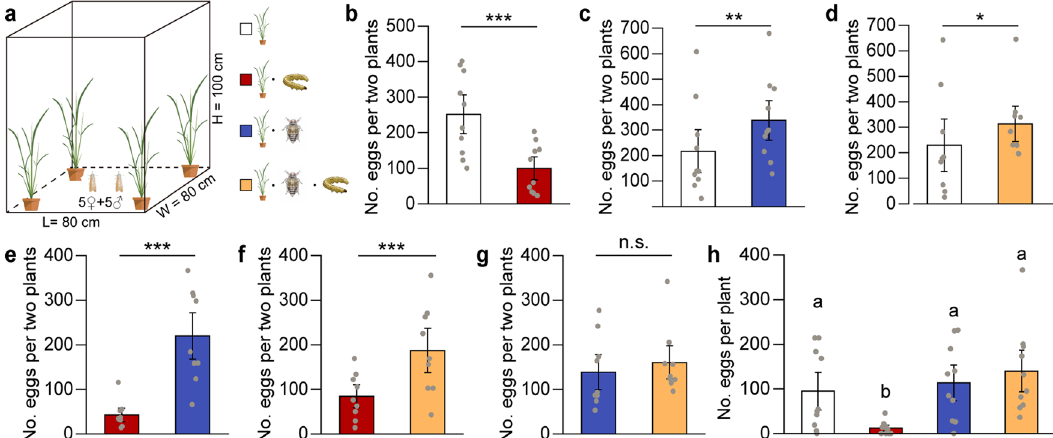
Fig. 2 Oviposition preference of SSB moths in greenhouse experiments. Number of eggs laid by female C. suppressalis on rice plants that were either uninfested (Control), infested by SSB larvae only (SSB), BPH only (BPH), or by both SSB and BPH (SSB/BPH). a Schematic drawing of the oviposition experiments. b Control versus SSB larva-infested plants ( n = 10). c Control versus BPH-infested plants ( n = 11). d Control versus dually infested plants ( n = 9). e SSB larva-infested plants versus BPH-infested plants ( n = 9). f SSB larva-infested plants versus dually infested plants ( n = 9). g BPH-infested plants versus dually infested plants ( n = 9). h SSB female moths were exposed to the four types of rice plants all together ( n = 10). For b – g , exact P - values = 3.52e-07 (Control vs SSB), 0.0068 (Control vs BPH), 0.032 (Control vs SSB/BPH), <2.2e-16 (SSB vs BPH), 9.03e-05 (SSB vs SSB/BPH), 0.20 (BPH vs SSB/BPH); For h , exact P -values = 2.15e-04 (Control vs SSB), 0.87 (Control vs BPH), 0.22 (Control vs SSB/BPH), <1e-04 (SSB vs BPH), <1e-04 (SSB vs SSB/BPH), and 0.67 (BPH vs SSB/BPH). Two-sided likelihood ratio test with generalized linear mixed model was conducted for the number of eggs (Poisson distribution error). Each bar represents the mean ± SE. Data columns with asterisks (*** P < 0.001, ** P < 0.01, * P < 0.05, or with different small letters ( P < 0.05) indicate signi fi cant differences between treatments; n.s. indicates a nonsigni fi cant difference ( P > 0.05).